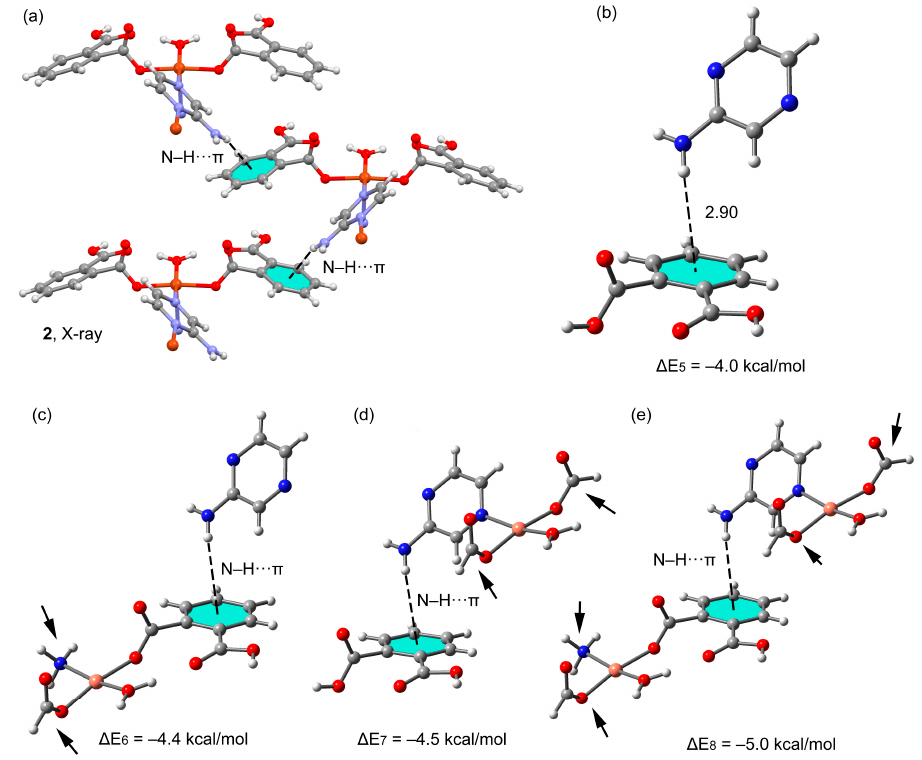
Figure 6. ( a ) X-ray fragment of compound 2 . ( b – e ) Theoretical models used to estimate the effect of the metal coordination on the N-H ··· π interactions. Distance in Å. The amino group from 2-aminopyrazine moiety that have higher occupancy factor has been taken into account for calculations and to draw the